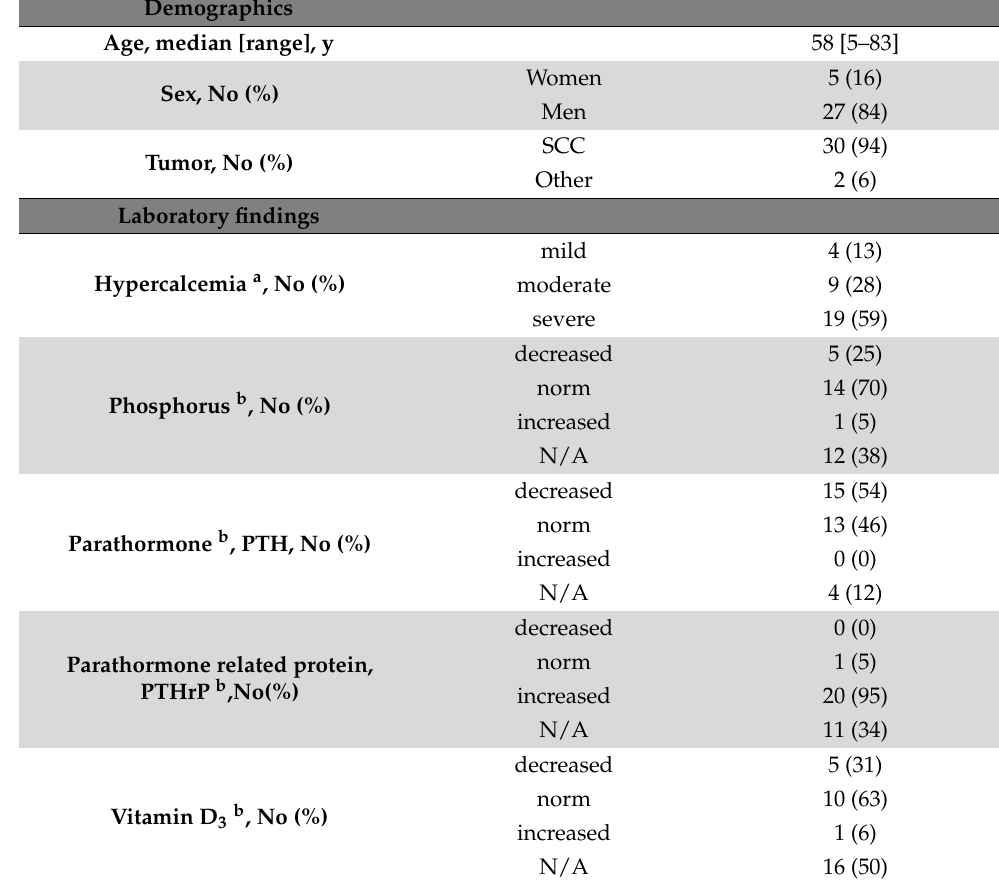
Table 3. Malignancy associated hypercalcemia in KSC patients: Core demographic and laboratory findings. No (%): Number (% cases with available